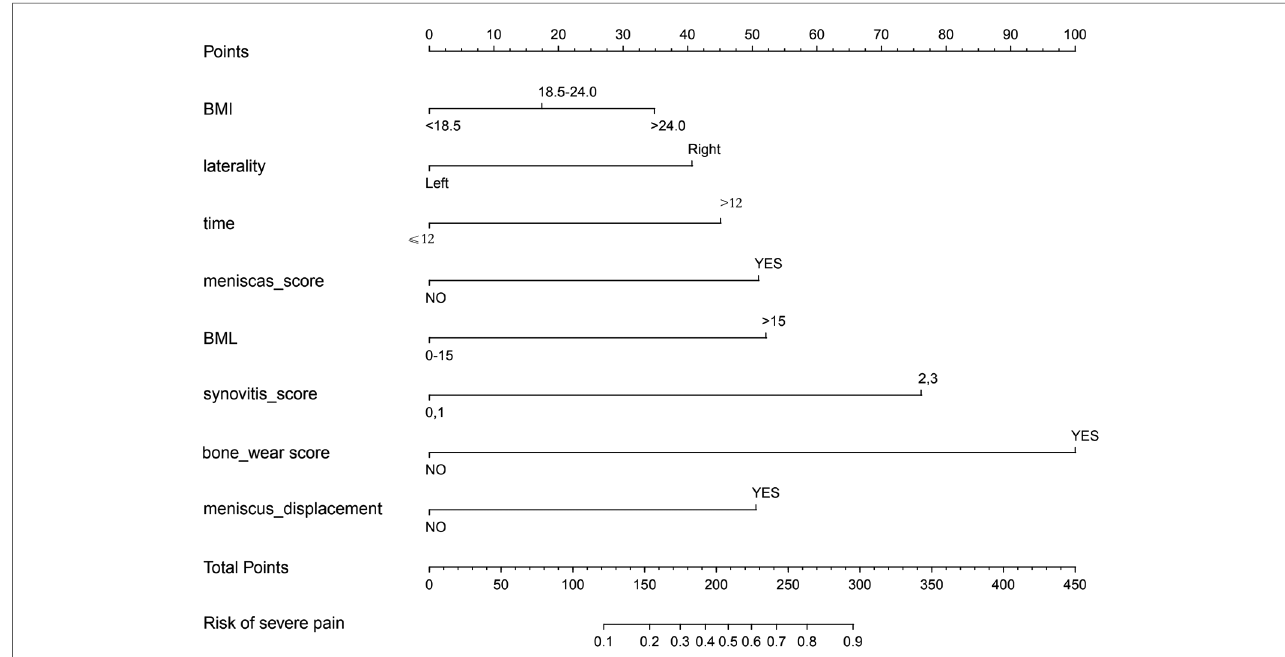
FIGURE 3 Nomogram drawn with 8 variables: BMI, affected side, duration of knee osteoarthritis, meniscal score, meniscal displacement, BML score, synovitis score, and bone wear score.